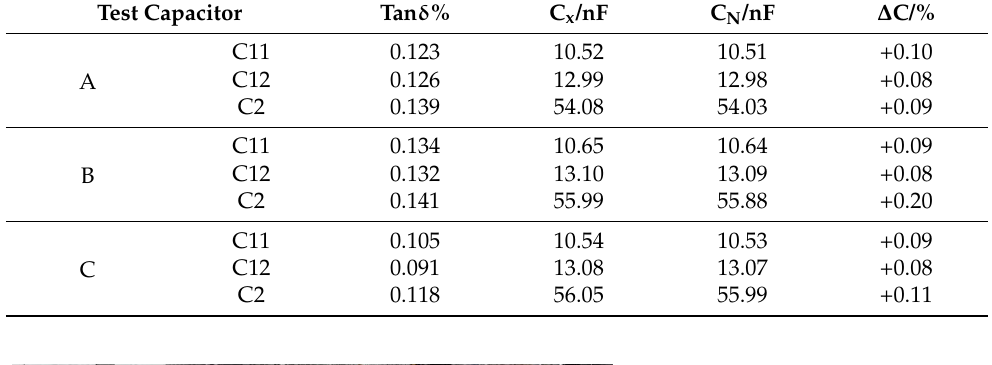
Table 3. Dielectric loss and capacitance test results.